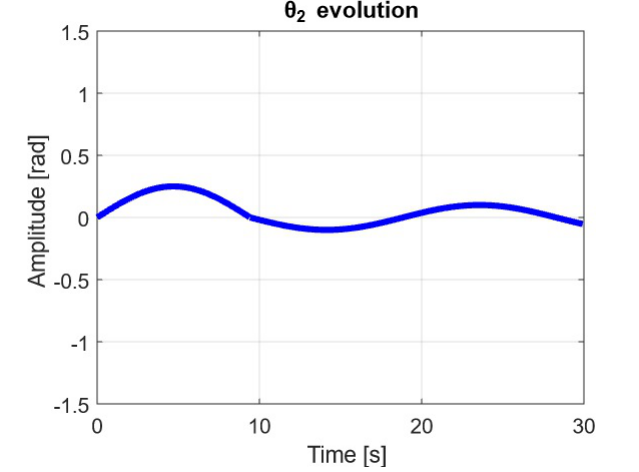
Figure 7. Swing angle θ 2 of the second pendulum along time achieved by the MPC-PD control system.